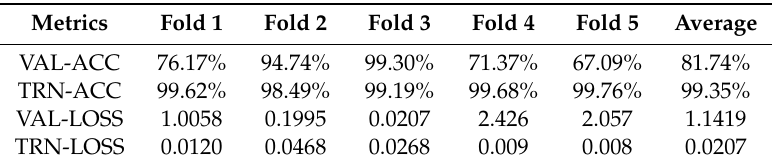
Table 4. Accuracy and loss scores for the multi-classification experiment (Exp#3a) with the detailed results of each fold of the 5-fold cross